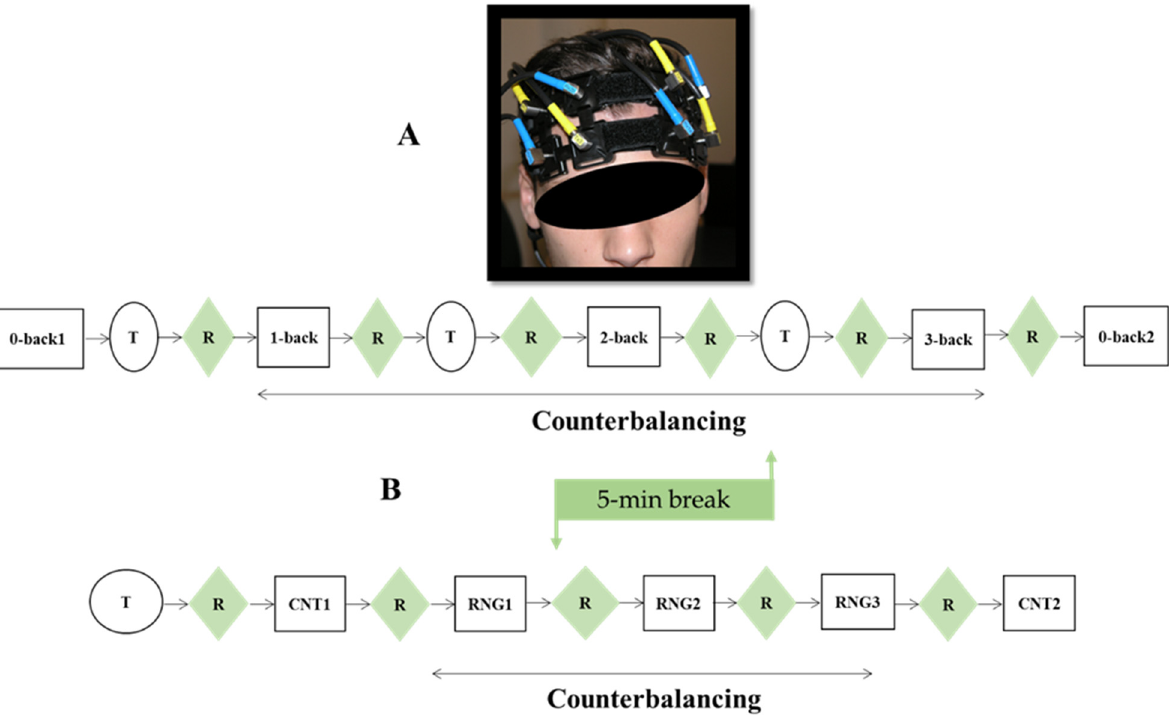
Figure 2. ( A ) Picture of the optode configuration setup on the forehead of one participant. ( B ) Schematic representation of the experimental course. R = 90-s pause; T = training; n-back counterbalancing = 1, 2, 3-back–1, 3, 2-back–2, 1, 3-back–2, 3, 1-back–3, 1, 2-back–3, 2, 1-back; RNG counterbalancing = RNG1, 2, 3–RNG1, 3, 2–RNG2, 1, 3–RNG2, 3, 1–RNG3, 1, 2–RNG3, 2, 1.